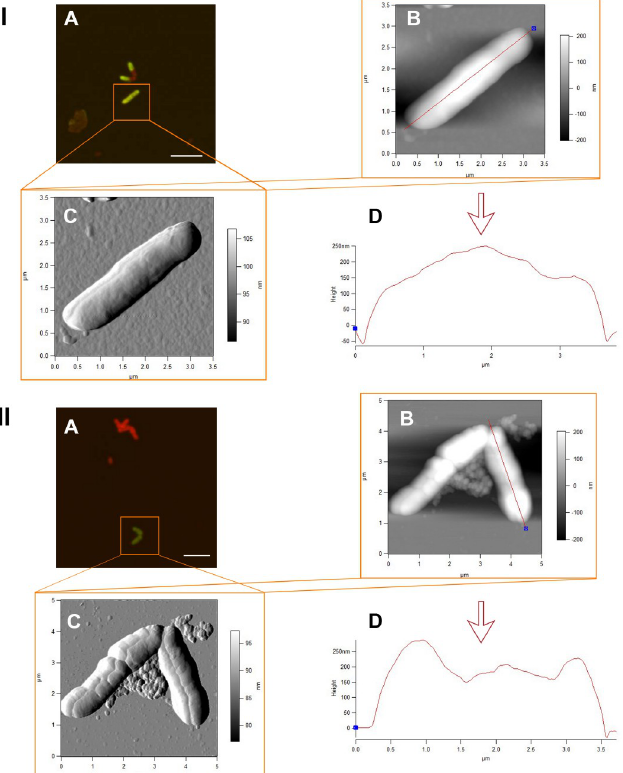
Fig 6. CLSM (A) and AFM (B, C) images and profiles (D) of R . cerastii IEGM 1278. Cells were grown for 24 h in the RS medium supplemented with 0.1% n -hexadecane (I) and 100 mg/L IBP and 0.1% n -hexadecane (II). The scale bars on the CLSM images correspond to 5 μ